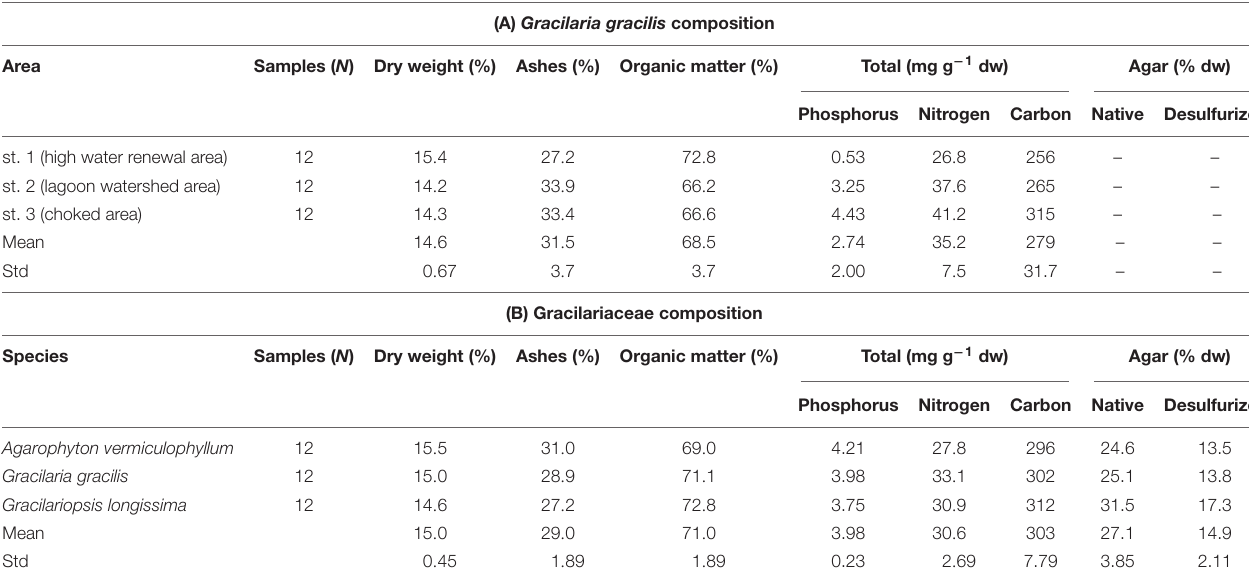
TABLE 1 | Composition of Gracilariaceae in different areas of the Venice Lagoon: (A) composition of Gracilaria gracilis found in 1994 in three very different areas: st. 1 (high water renewal area), st. 2 (watershed area), and st. 3 (choked area) (Sfriso et al., 1994); (B) mean composition of different Gracilariaceae recorded at sts. a and b in the choked